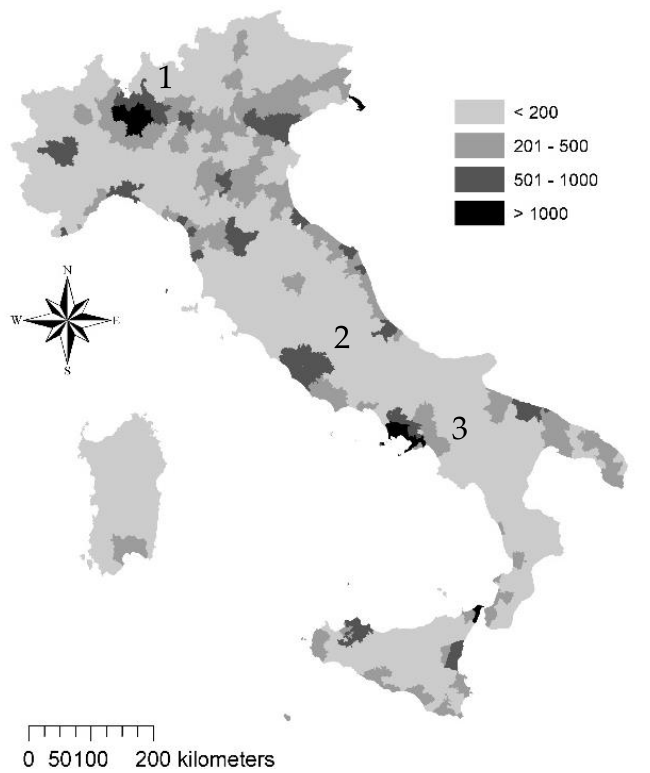
Figure 1. Population density (inhabitants/km 2 ) in Italy at 2011 census (the specific locations of Milan: 1; Rome: 2, and Naples: 3, are shown).